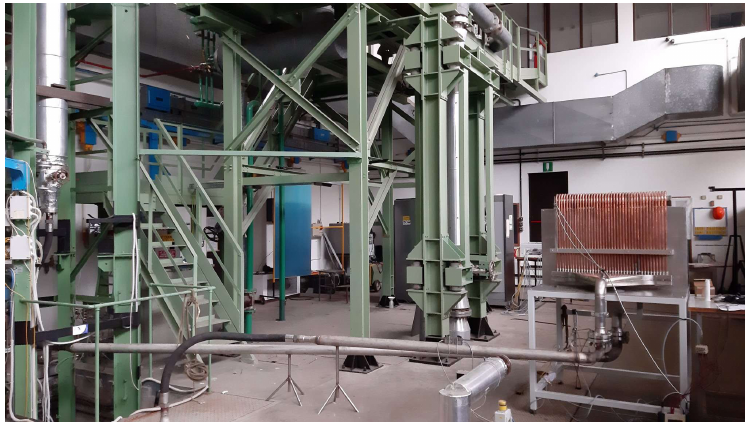
Figure 6. DEMO divertor OVT prototype installed into the CEF1